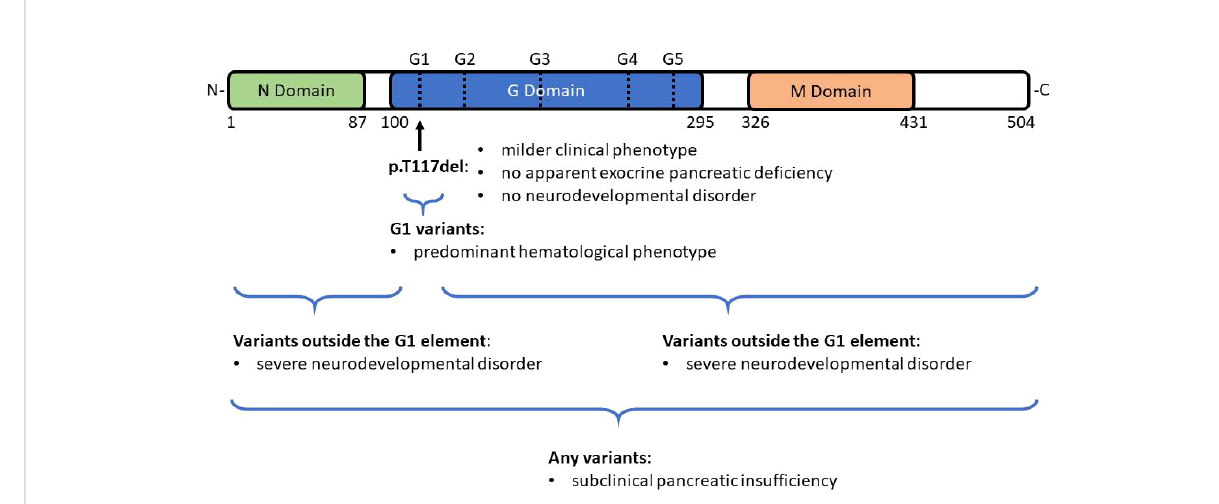
FIGURE 4 Domain structure of SRP54. SRP54 has three functional domains: N-terminal domain (N-domain), central GTPase domain (G domain), and C- terminal domain (M domain). All the mutated residues in SRP54 are located around the G domain which contains fi ve speci fi c G elements (G1- G5). G1 variants, like the recurrent p.T117del mutation have been associated with a predominant hematological phenotype. In contrast, patients with G variants that reside outside the G1 element present with a severe neurodevelopmental disorder and in some cases with exocrine